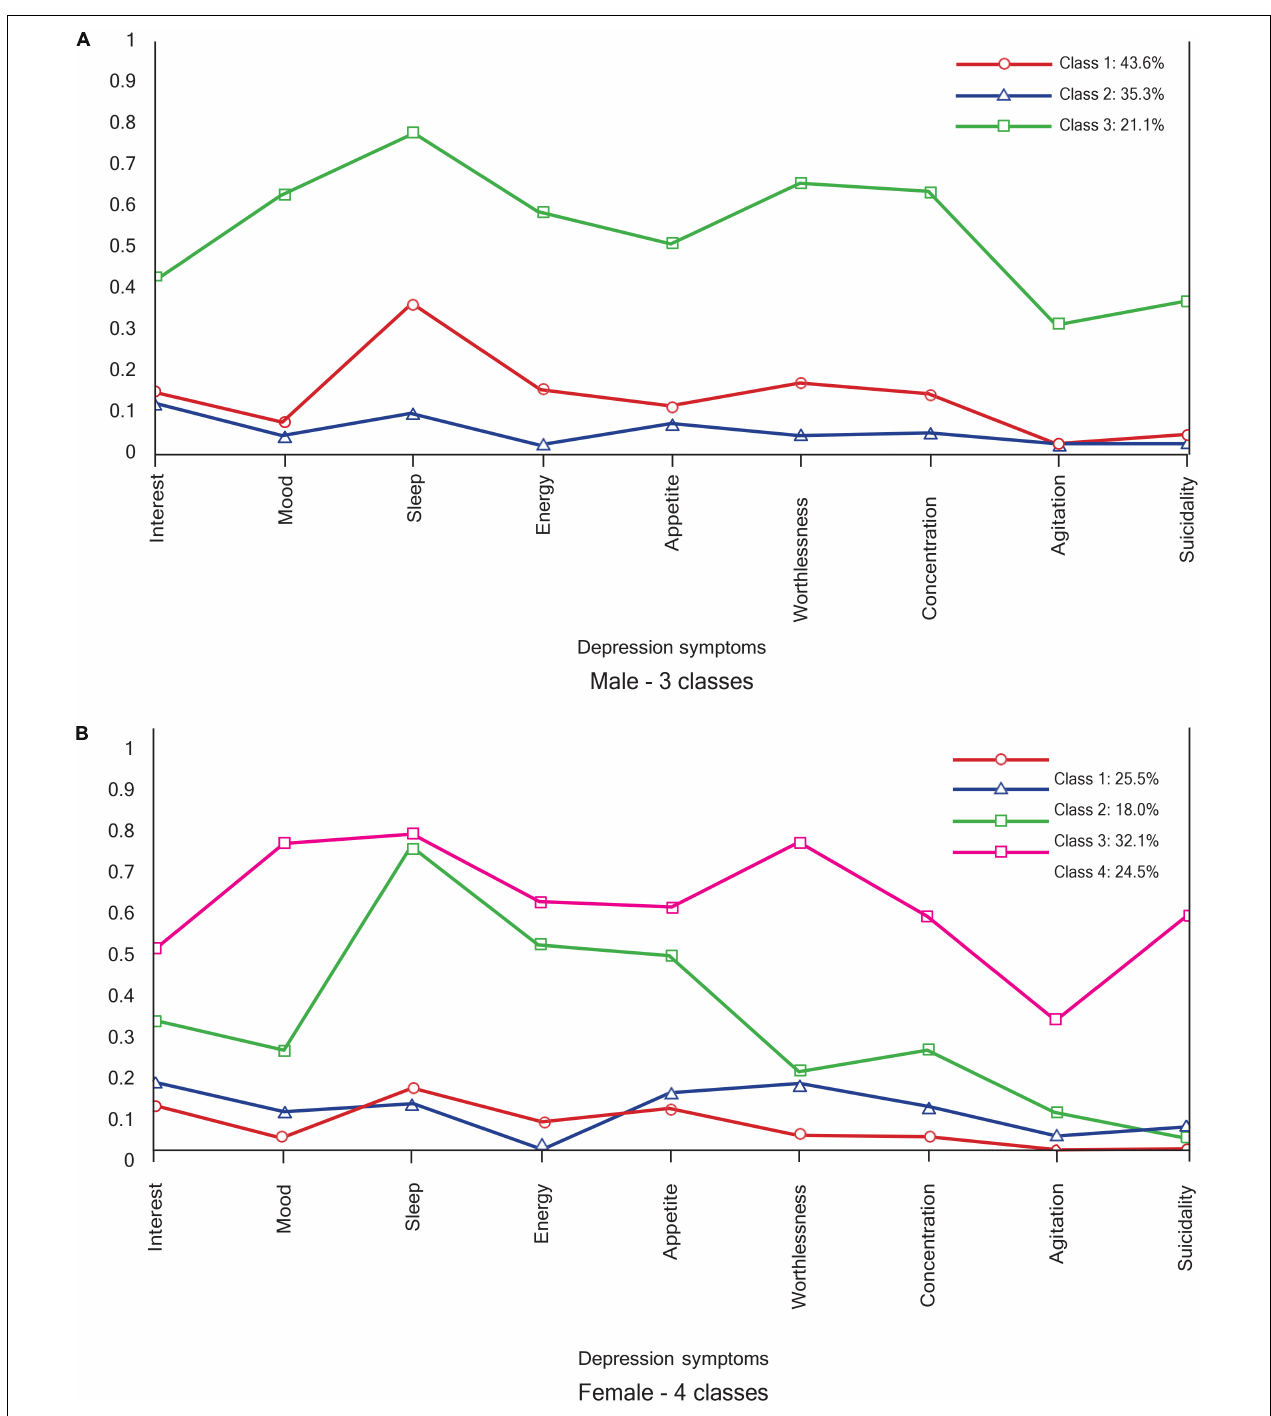
FIGURE 3 | Depression profiles. (A) Male – 3 classes. (B) Female – 4 classes.